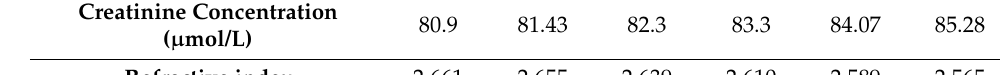
Table 1. The blood sample’s refractive index at various concentrations of creatinine.